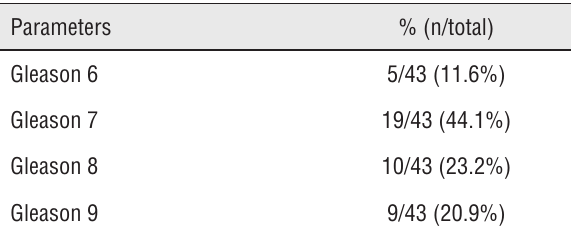
Table 3 - Distribution of Gleason score (6, 7, 8, 9 and 10) in groups for patients with sPCa.